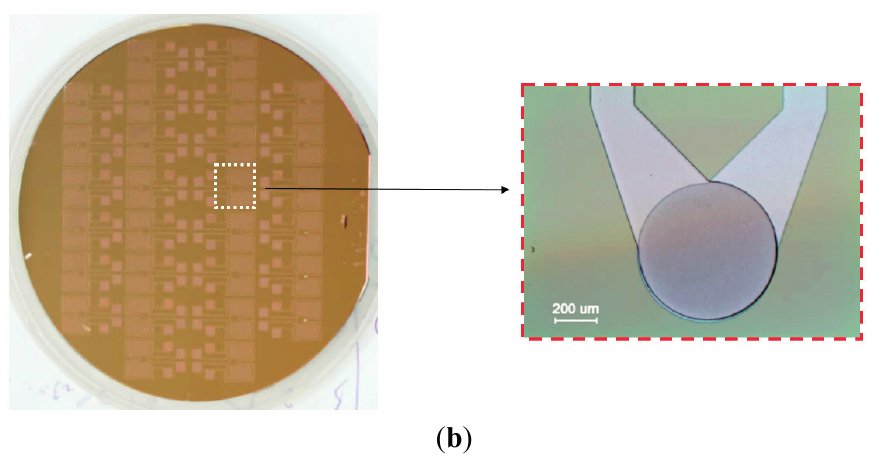
Figure 2. Fabricated ice sensor array on the silicon wafer. ( a ) Capacitive ice sensor (front); ( b ) Thermocouple (back)